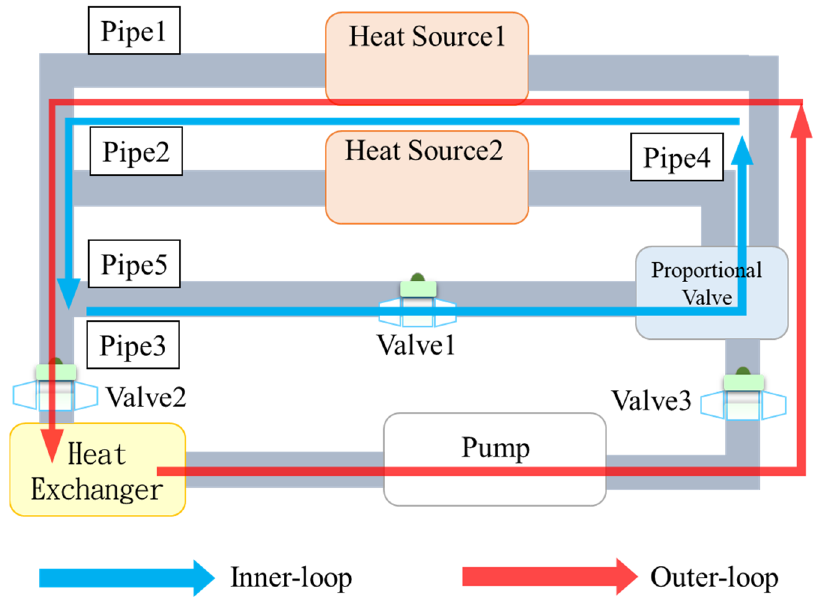
Figure 1. System configuration of the innovative IHTMS designs.